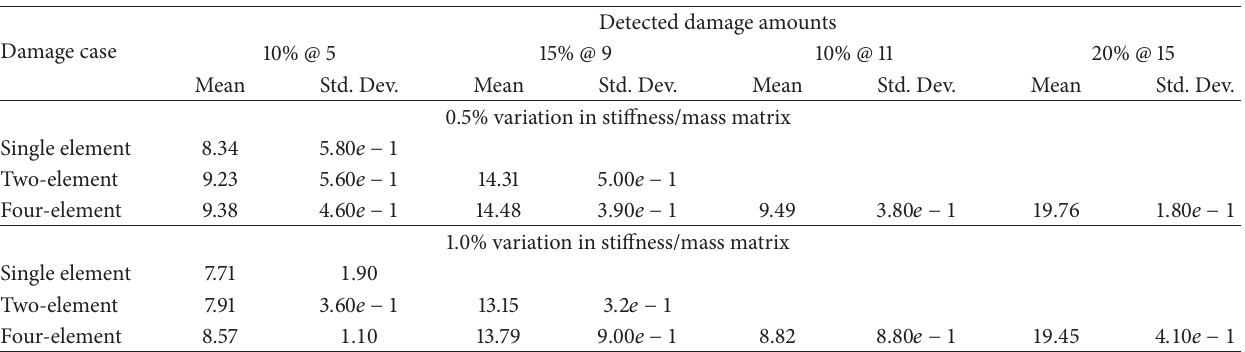
Table 4: Damage detection results considering variation in stiffness/mass